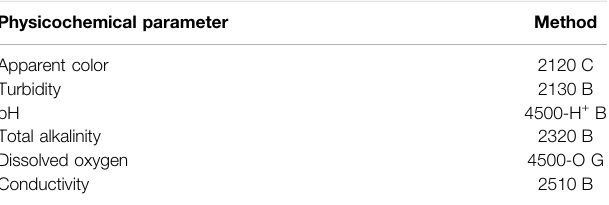
TABLE 1 | Parameters and methods used for the physicochemical analysis of the water collected at Jataizinho WTP. Physicochemical